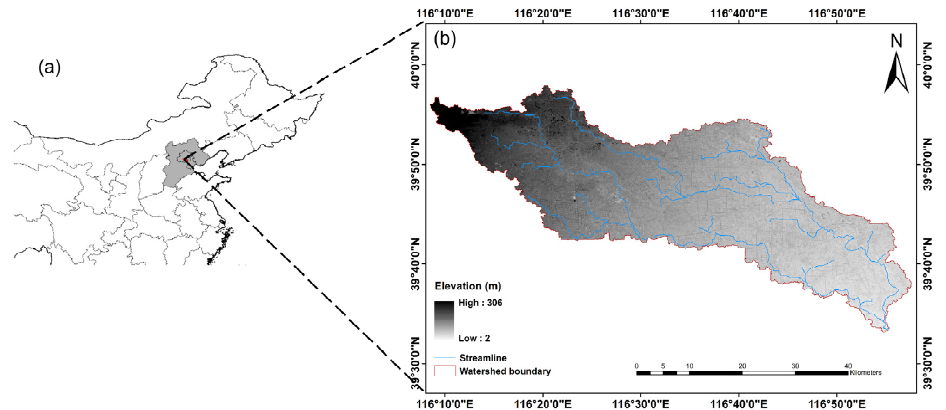
Figure 1. Map of the study area. Location of Liangshuihe catchment in Beijing, China ( a ). Study area boundary ( b ).